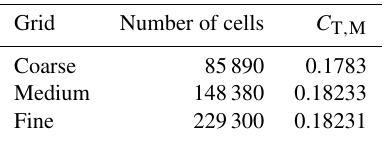
Table 1. Grid statistics for the grid independence study of the ref- erence